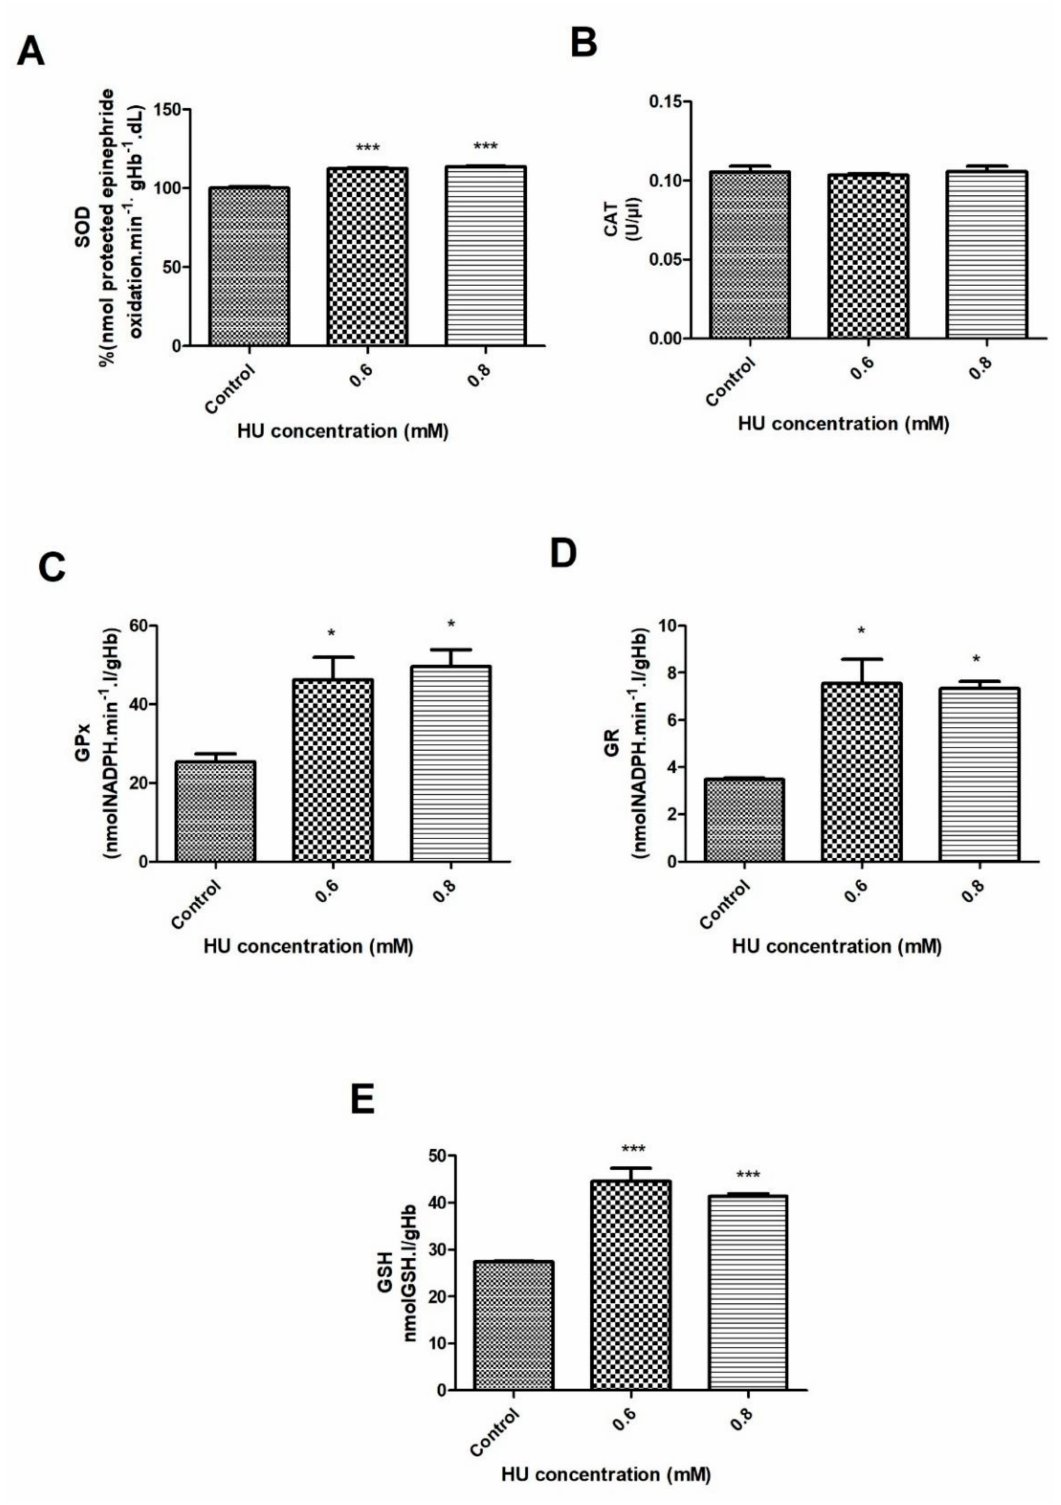
Figure 3. Enzymatic activity of the erythrocyte antioxidant system in the control samples that were treated with 0.6 and 0.8 mM HU ( n = 3) for 30 min. Hemolysate was used to measure ( A ) Superoxide dismutase (SOD); ( B ) Cata- lase (CAT); ( C ) Glutathione peroxidase (GPx); ( D ) Glutathione reductase (GR); ( E ) Reduced glutathione. In all of the cases, * it represents a comparison between the control groups and the treated groups (* p < 0.05 and *** p <